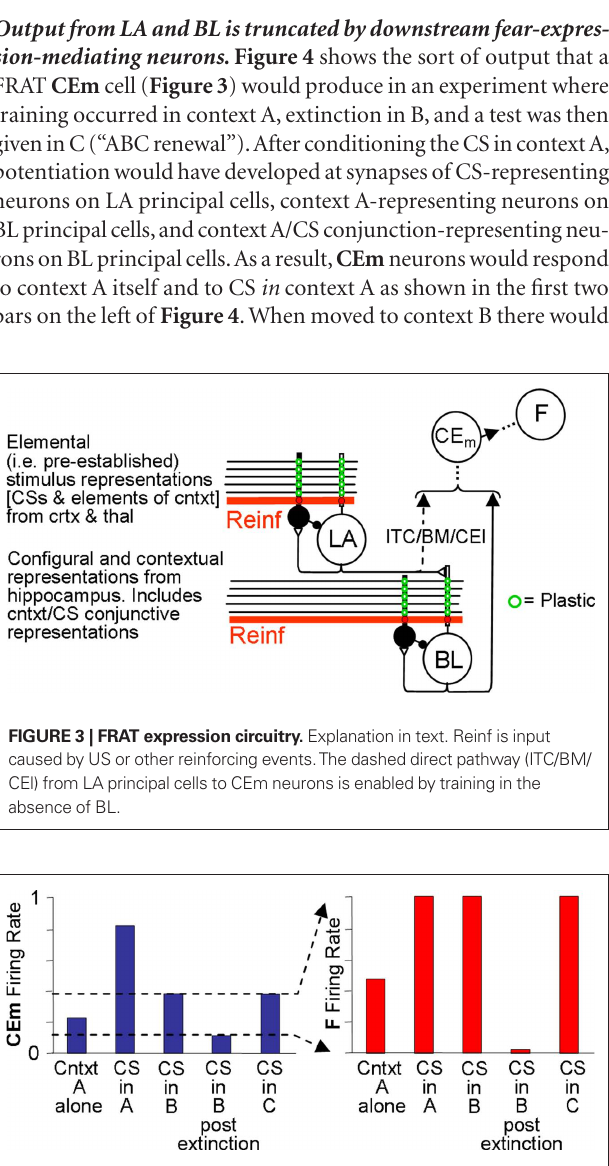
FigurE 4 | relation between CEm and F activity. Explanation in